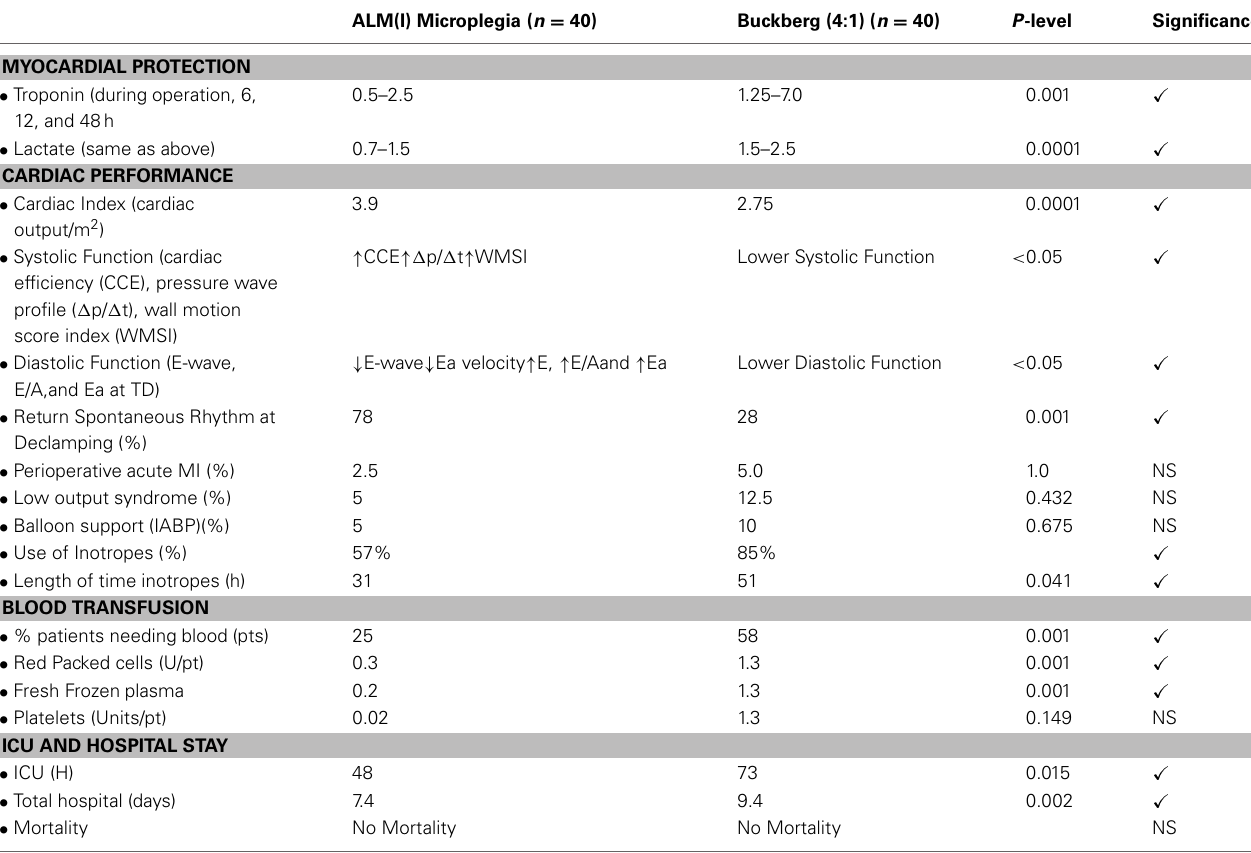
Table 1 | Prospective Randomized Human trial data comparing Microplegia ALM(I) with 4:1 Buckberg Solution. ALM(I) Microplegia ( n =